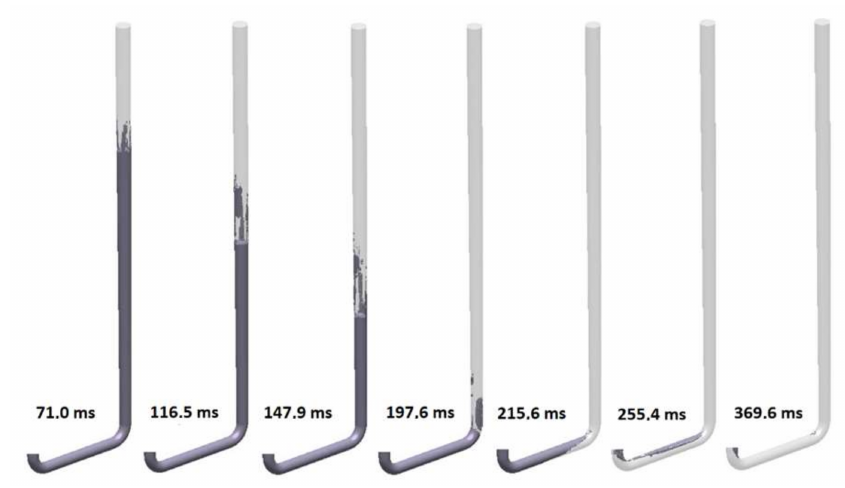
Figure 26. Air evacuation in round sprue with straight taper (S s 5), MAGMASOFT.